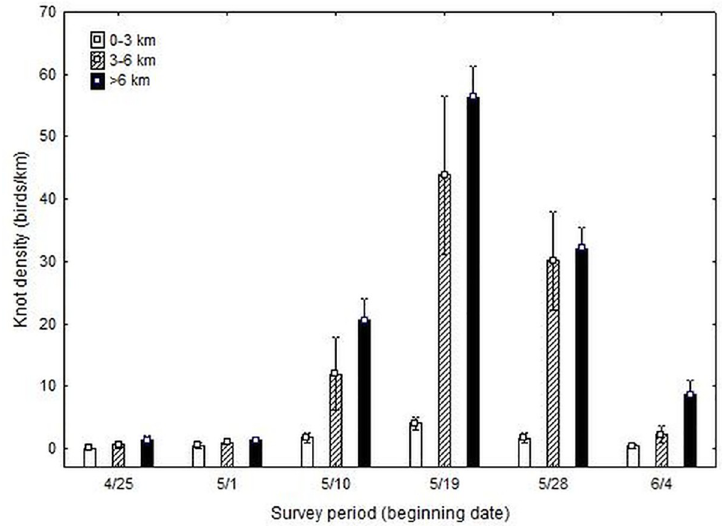
Fig 2. Results of weekly aerial surveys (2006–2009) for red knots along the Virginia barrier islands. Knots were mapped and assigned to beach segments according to their proximity (0–3, 3–6, > 6 km) to active peregrine falcon eyries. Knot densities were calculated for proximity categories for each survey (6 weekly surveys/year). Means and standard errors are presented for weeks and proximity categories across years.